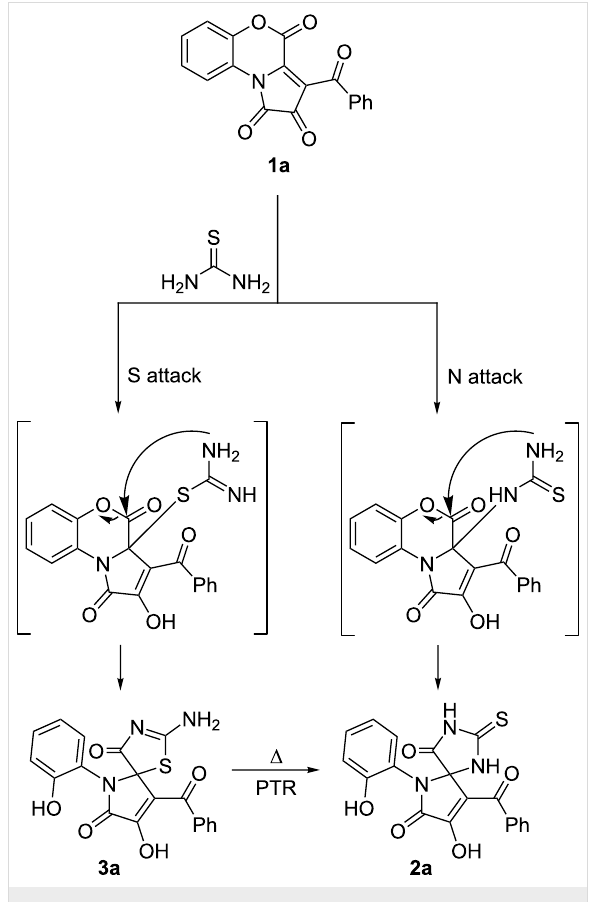
Scheme 6: Pathways for the formation of compound 2a